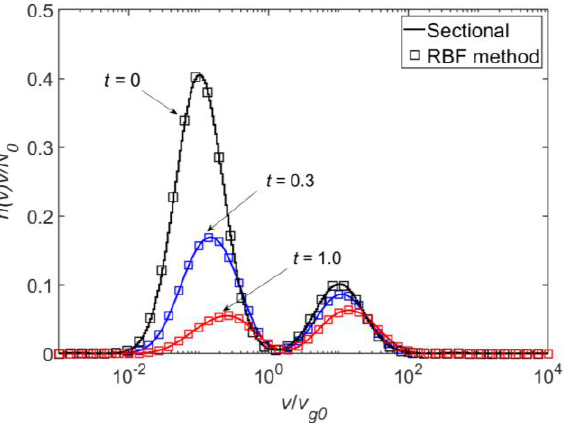
Figure 5. Self-preserving distributions predicted using the RBF and the sectional methods for Brownian coagulation under the continuum and free-molecular regimes.